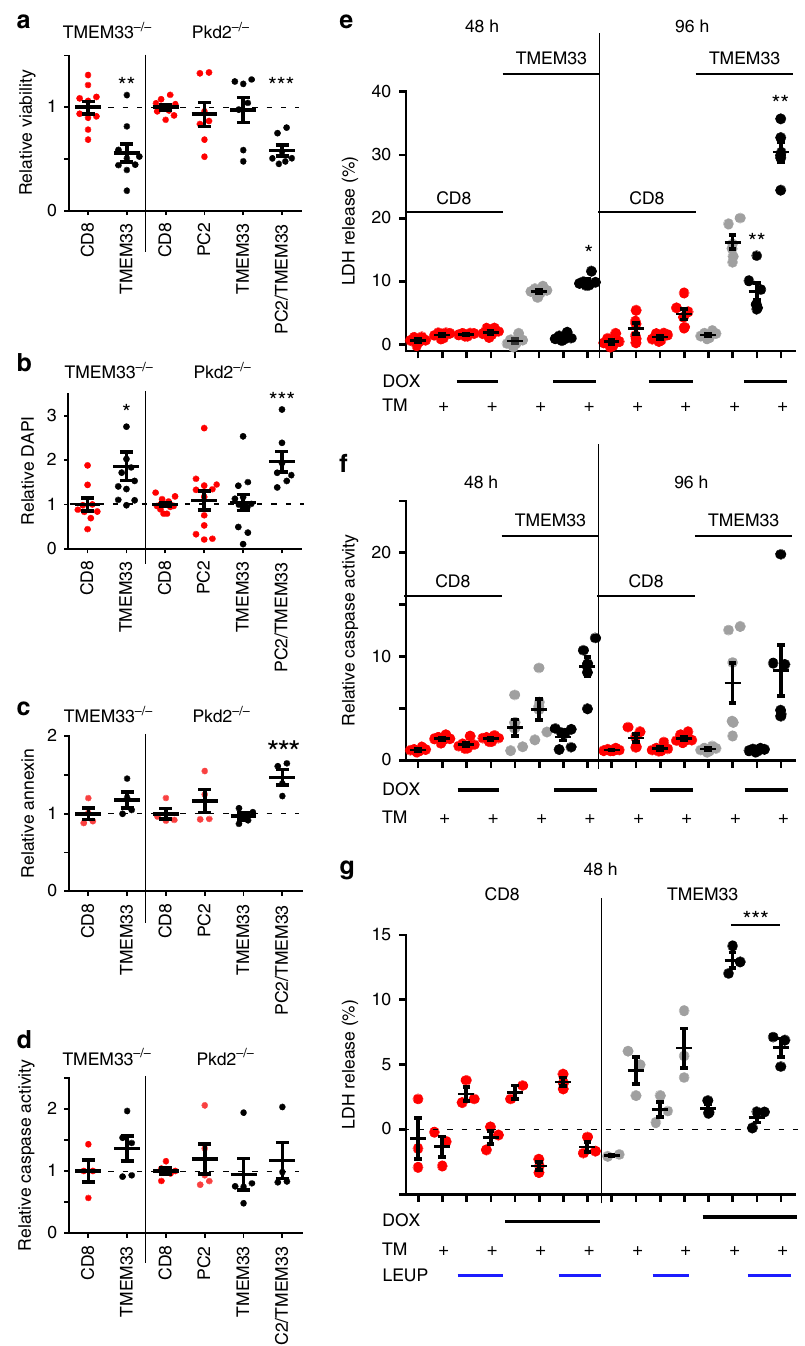
Fig. 6 TMEM33 overexpression induces cytotoxicity in a PC2-dependent manner. a Cell viability determined by measuring the number of Cherry positive cells using a cell sorter. CD8ER (red dots) was used as a negative control. Cells were transfected with TMEM33 (black dots) or PC2 alone (red dots), or with the mix TMEM33/PC2 (black dots). The relative (to the CD8ER conditions) number of viable cells expressing Cherry is illustrated. b Relative number of DAPI positive cells. One TMEM33 complemented TMEM33 − / − data point (4.66) is out of scale. c Relative number of annexin positive cells. d Relative caspase 3/7 activity. e LDH release in either a conditional PCT cell line expressing CD8ER (in red) or TMEM33 (in black), without (in gray) or with DOX induction (in black) at 48 and 96 h. Cells were treated with vehicle (DMSO) or TM (1 μ g/ml) for 16 h. f Same for caspase 3/7 activity. g Effect of the cathepsins inhibitor leupeptin (LEUP; 25 μ M) on LDH release in a conditional PCT cell line expressing TMEM33 (black dots) or CD8ER (red dots) without or with DOX induction (48 h), as indicated. Values are means ± SEM overlaid with dot plots. One star indicates p < 0.05, two stars p < 0.01 and three stars p < 0.001, with a one-way permutation test used to evaluate statistical signi fi cance. Source data are provided as a Source Data fi